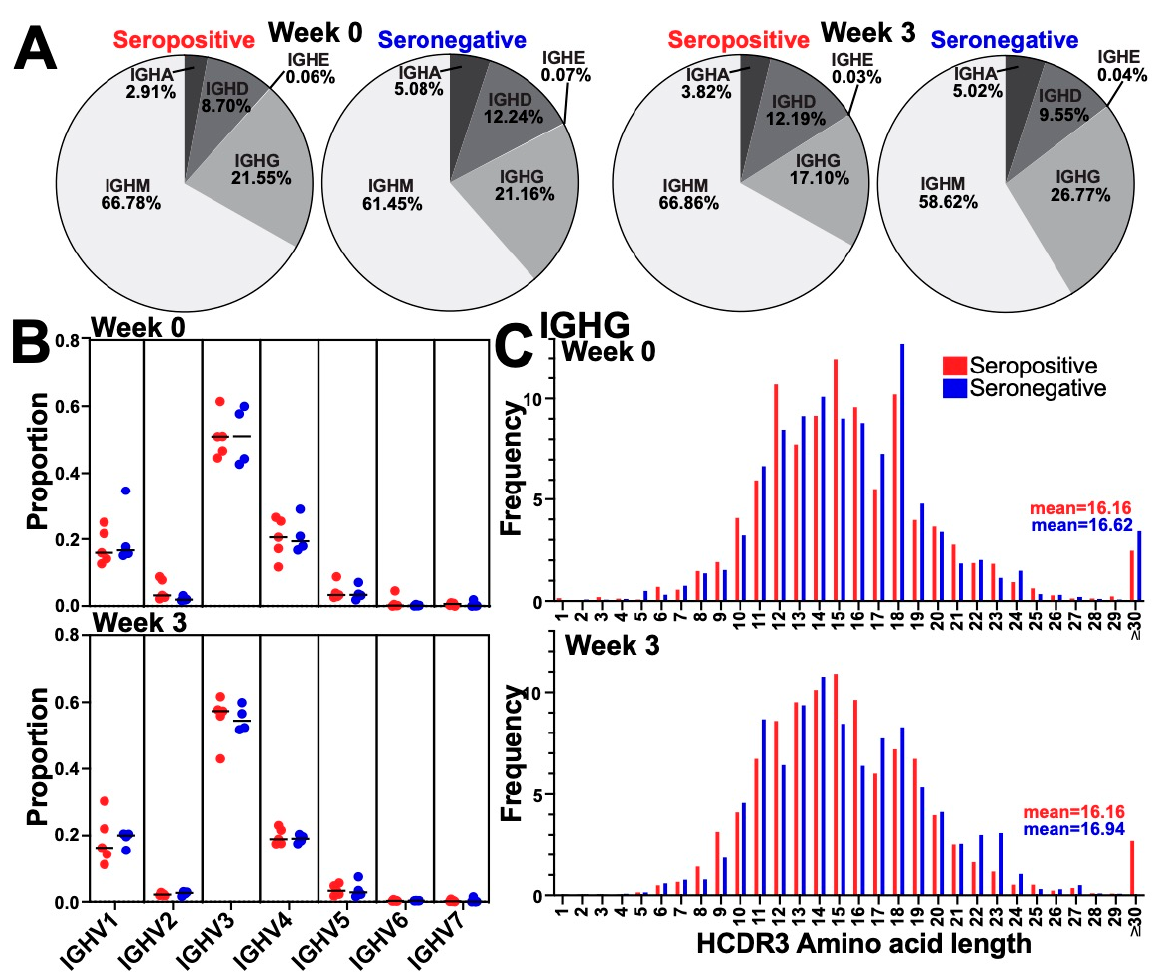
Figure 2. Isotype usage, V gene usage, and HCDR3 length of BCR repertoire across serotypes during vaccination. ( A ) BCR isotype usage (IgM IgG, IGHD, IgA, and IGHE) for seropositive and seronegative individuals at each time point (week 0, week 3): percentages as indicated. No changes were seen in the proportion of any isotype due to vaccination, nor significant variation observed between serotypes. ( B ) IgG Heavy chain V gene usage (IGHV1-7) of IgG clonotypes. Proportion as indicated for seropositive (red) and seronegative (blue). No significant differences were observed between serotypes at week 0 and week 3, and no changes within serotype over time were observed. ( C ) Distribution of IgG heavy chain complementary determining region 3 (HCDR3) lengths of IgG clones for week 0 and week 3. Seropositive (red) and seronegative (blue) and mean HCDR3 length are shown. No significant changes in the distribution of HCDR3 lengths were seen between serotypes at either time point, or within serotype between weeks.